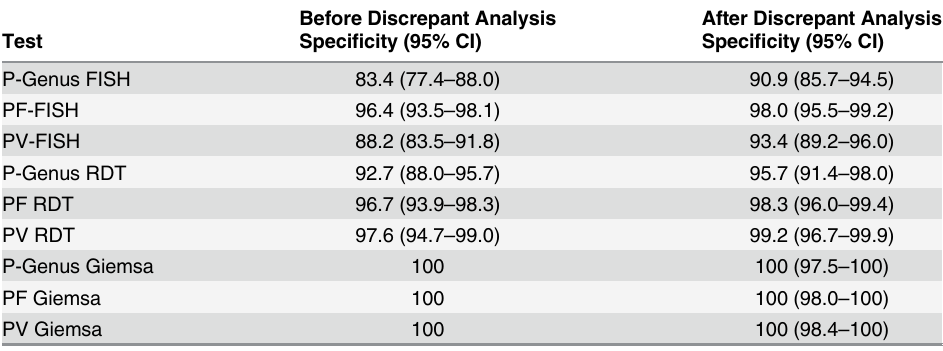
Table 4. Specificity of Plasmodium FISH tests and RDTs as compared to Giemsa. After discrepant anal- ysis: Including FISH and PCR positive but Giemsa negative samples as true positives ” . P-Genus FISH -17; PF-FISH – 5; and PV-FISH – 14. CI — confidence